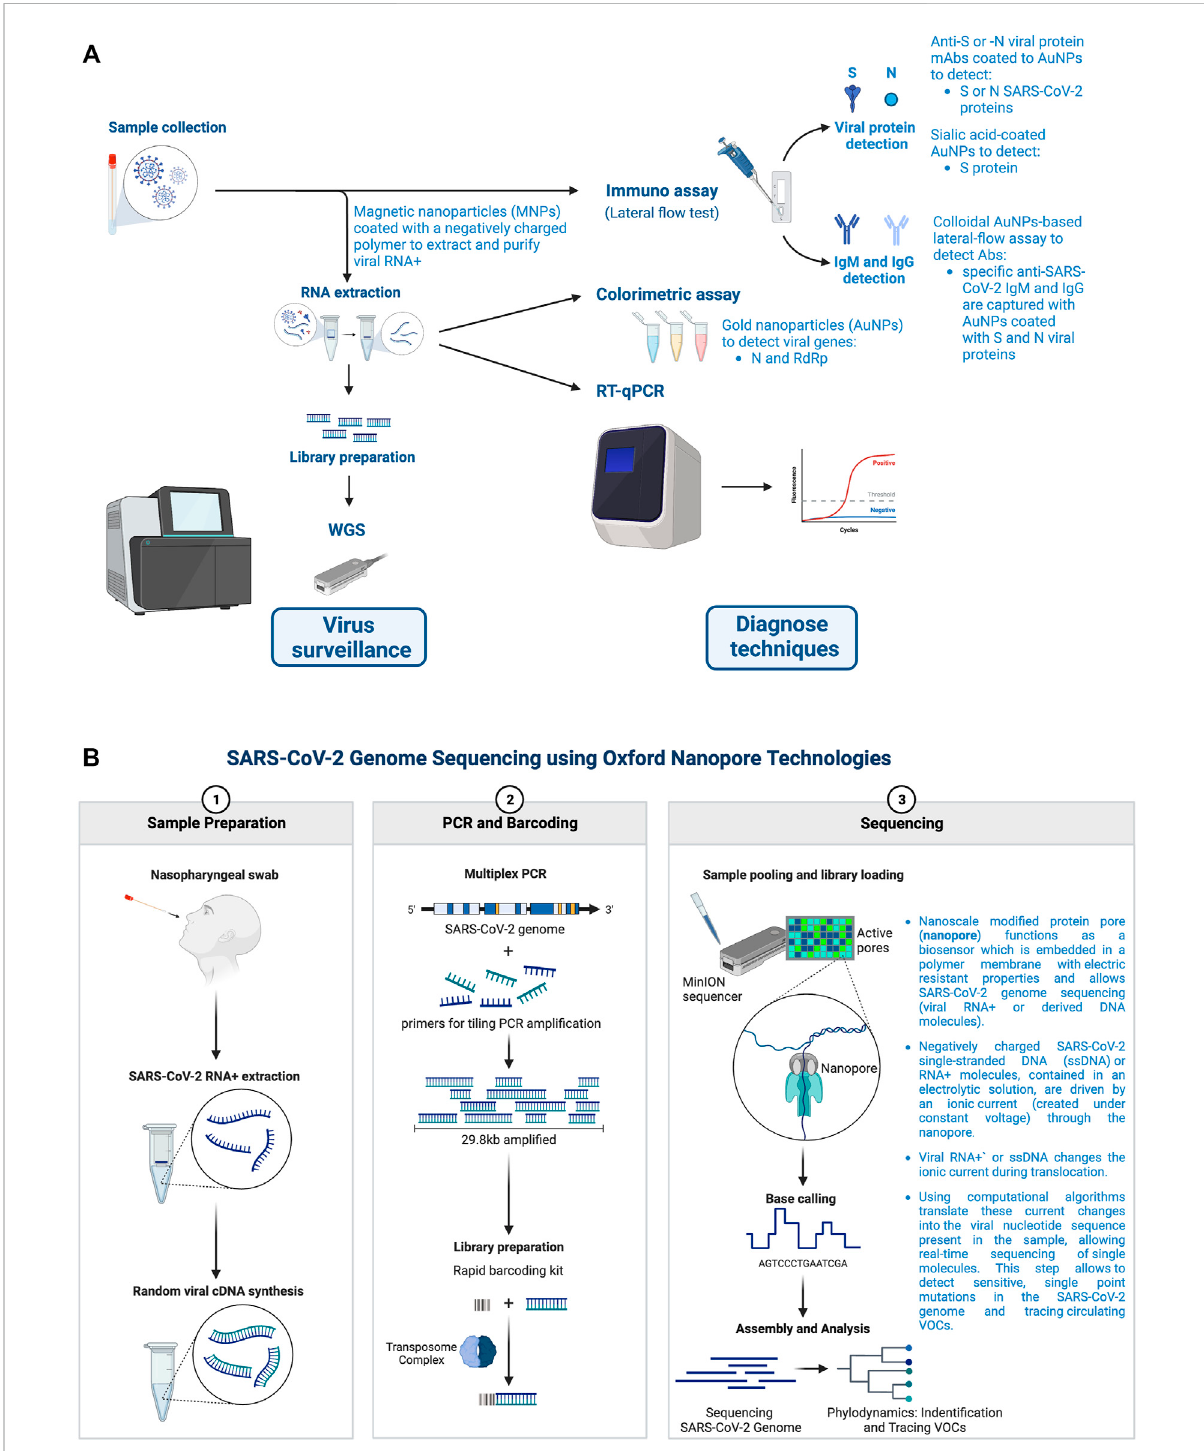
FIGURE 4 Nanotechnology and reagents used for genome sequencing technologies and serological approaches for SARS-CoV-2 surveillance and diagnose. (A) Viral RNA+ extraction from patients ’ samples have allowed to prepare a library or primers for WGS that is very useful for virus surveillance and the detection of VOCs bearing key mutations associated with immune responses escape and vaccine breakthrough. Likewise, viral RNA+extractionhavepermittedtodevelopspeci fi c,sensitive,scalable,rapidandlow-costRT-qPCRtestsfordiagnose,bothinhospitalsandin PoC facilities. Nanomaterials used for RNA+ isolation and puri fi cation that allow scalation of RT-qPCR and other gene-based diagnose tests